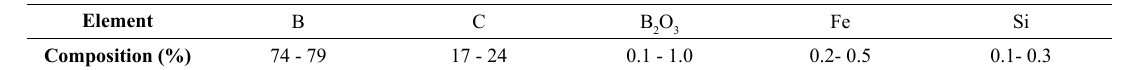
Table 2. Chemical composition of B